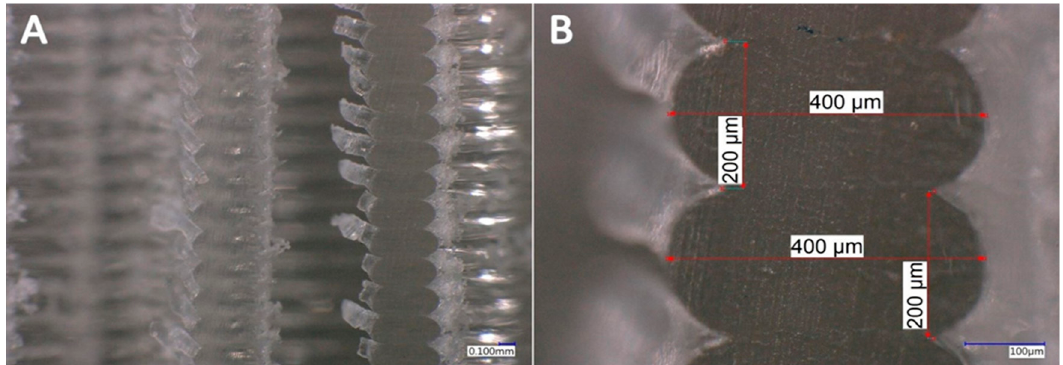
Figure 13. Microscopic cross-section image of 3D-printed sample with 2.4 ILD before compression test (cyclic loading–unloading). ( A ) 100× magnification setting, ( B ) 500× magnification setting.